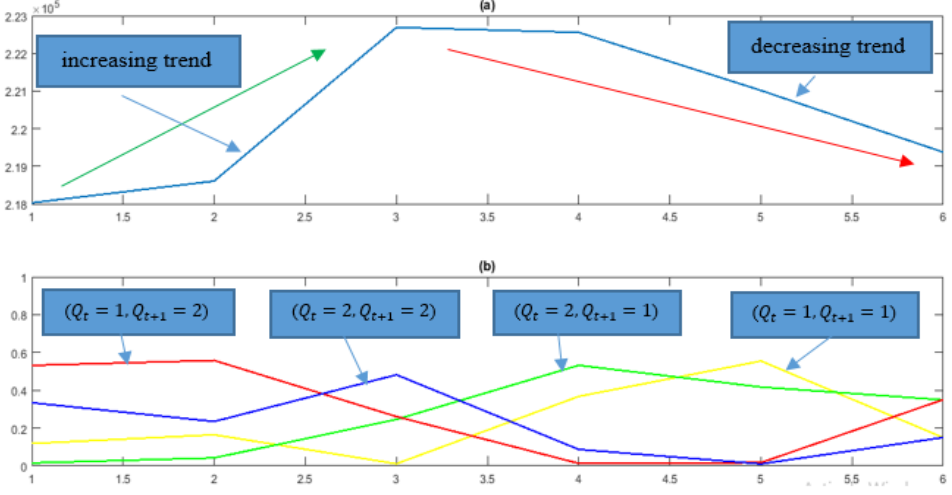
Figure 7. (a). The sample path of the Automotive Industry Index for the period of April 29, 2021, to May 3, 2021, (b). the estimated elements of joint conditional probability matrix for the best selected model (MS-SEMI-K(1)), the colors of red, blue, green, and yellow are the joint conditional probability of ( ), ( ), ( ) and ( ),